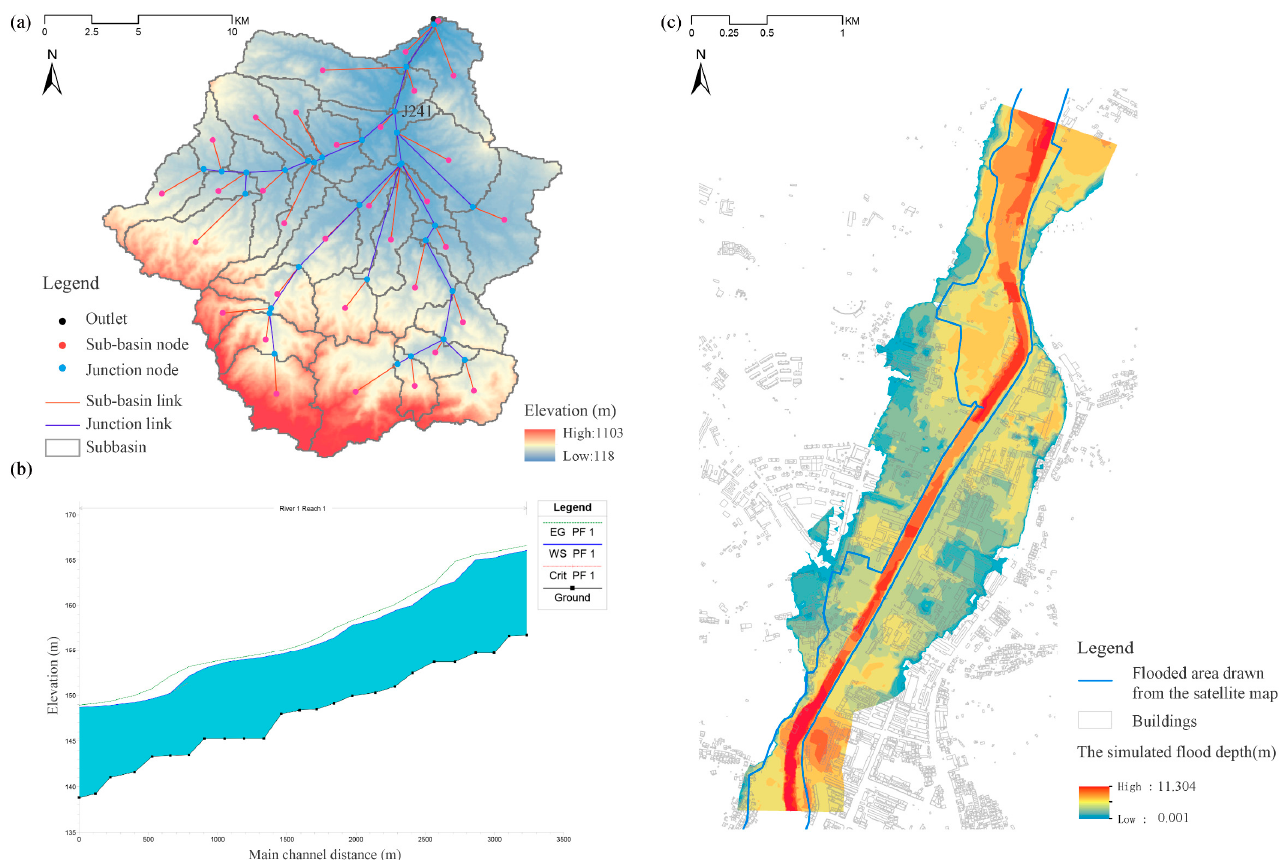
Figure 10. Model and results of HEC-HMS and HEC-RAS. ( a ) Schematic map of the HEC-HMS and Junction J241 as the control point; ( b ) Water table profile diagram of HEC-RAS; ( c ) Comparison between the actual flooded area drawn from the satellite map after the disaster and the simulated inundation area in RT II.